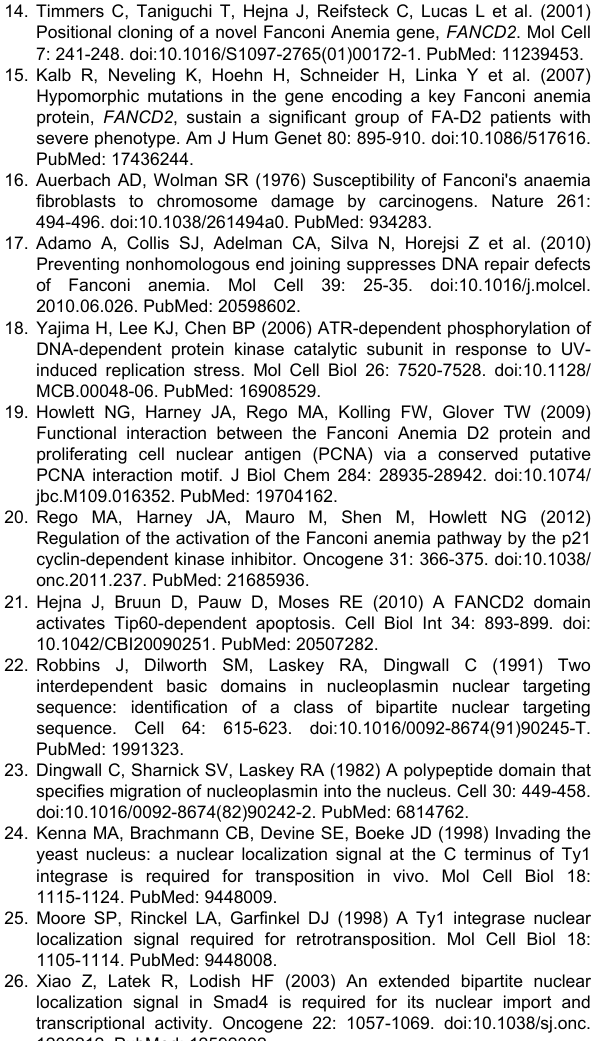
Table S1. Detection of importin subunit β1, NUP160 and NUP155 in FANCD2 immune complexes. FANCD2 immune complexes were analyzed using a LTQ Orbitrap Velos hybrid mass